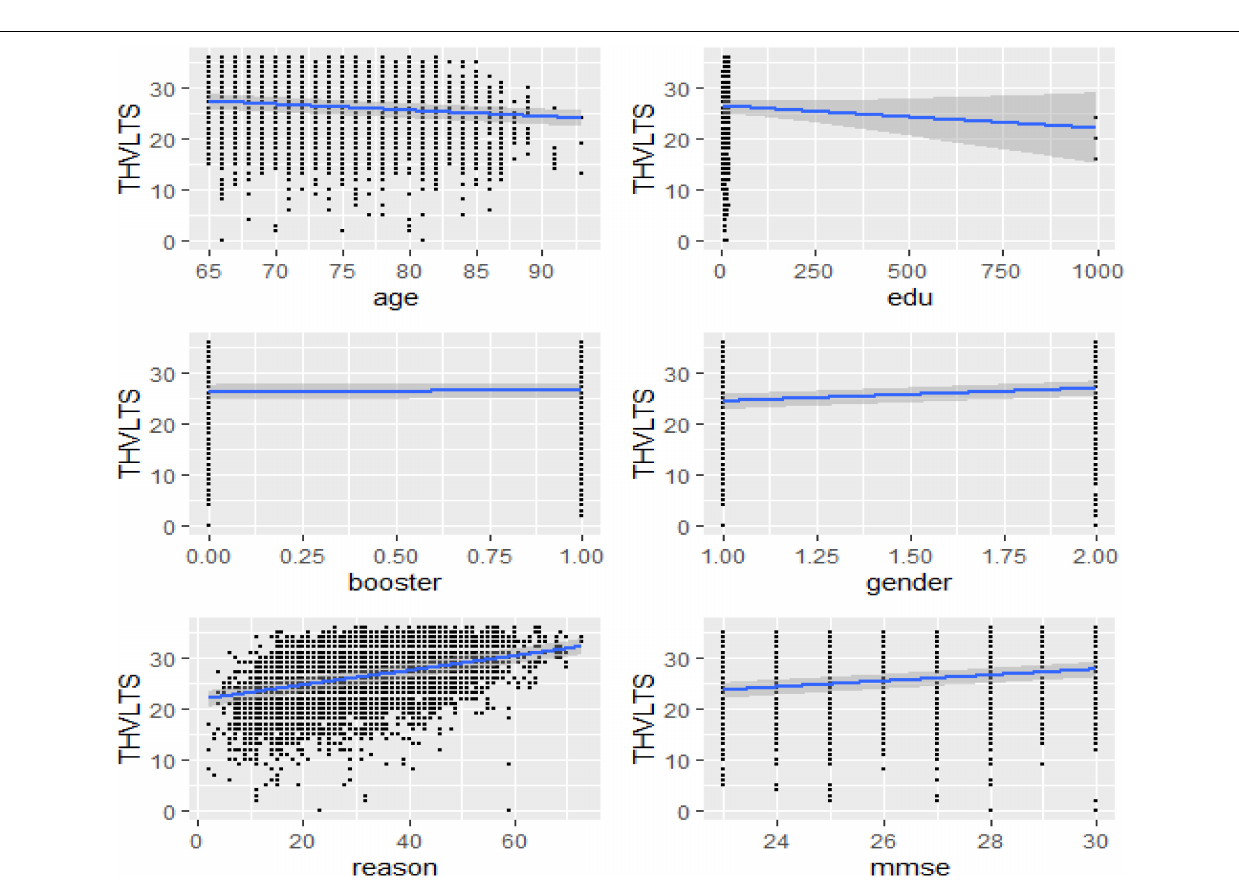
FIGURE 5 | Bayesian hierarchical varying slope model marginal prediction